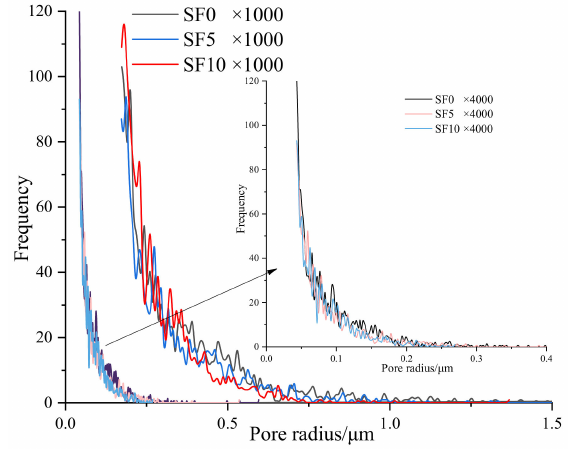
Figure 5. Pore size distributions of different samples obtained by image processing.